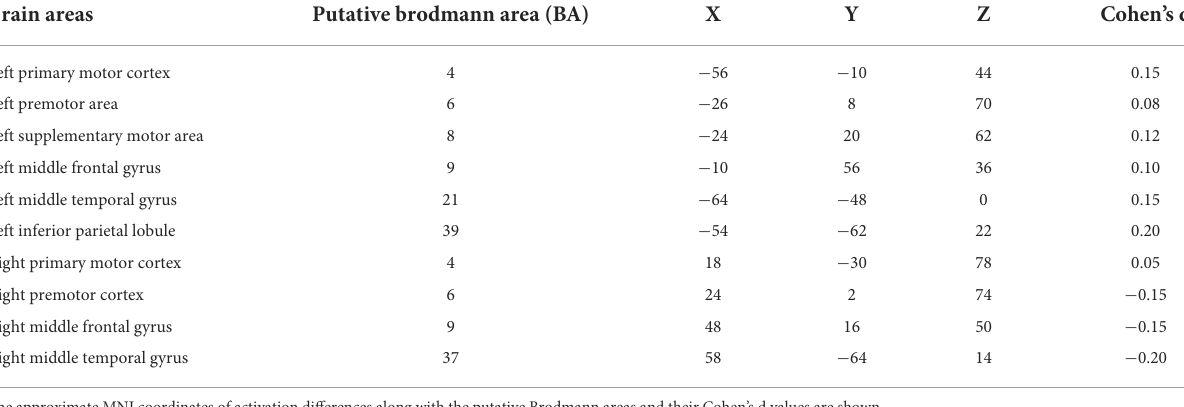
TABLE 1 Brain areas showing differential activation effects in the decision-making phase during the intention to turn as compared to the waiting phase. Brain areas